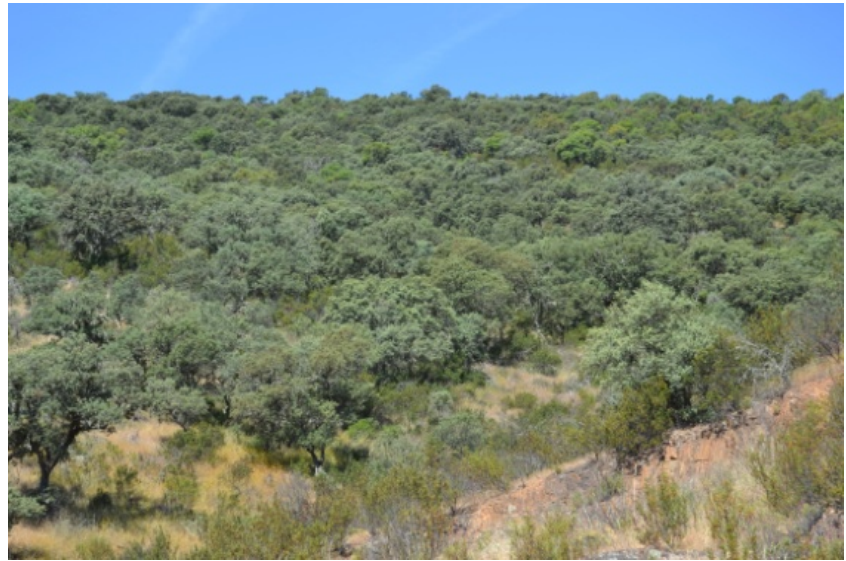
Figure 15. Pyro bourgaeanae – Quercetum rotundifoliae .